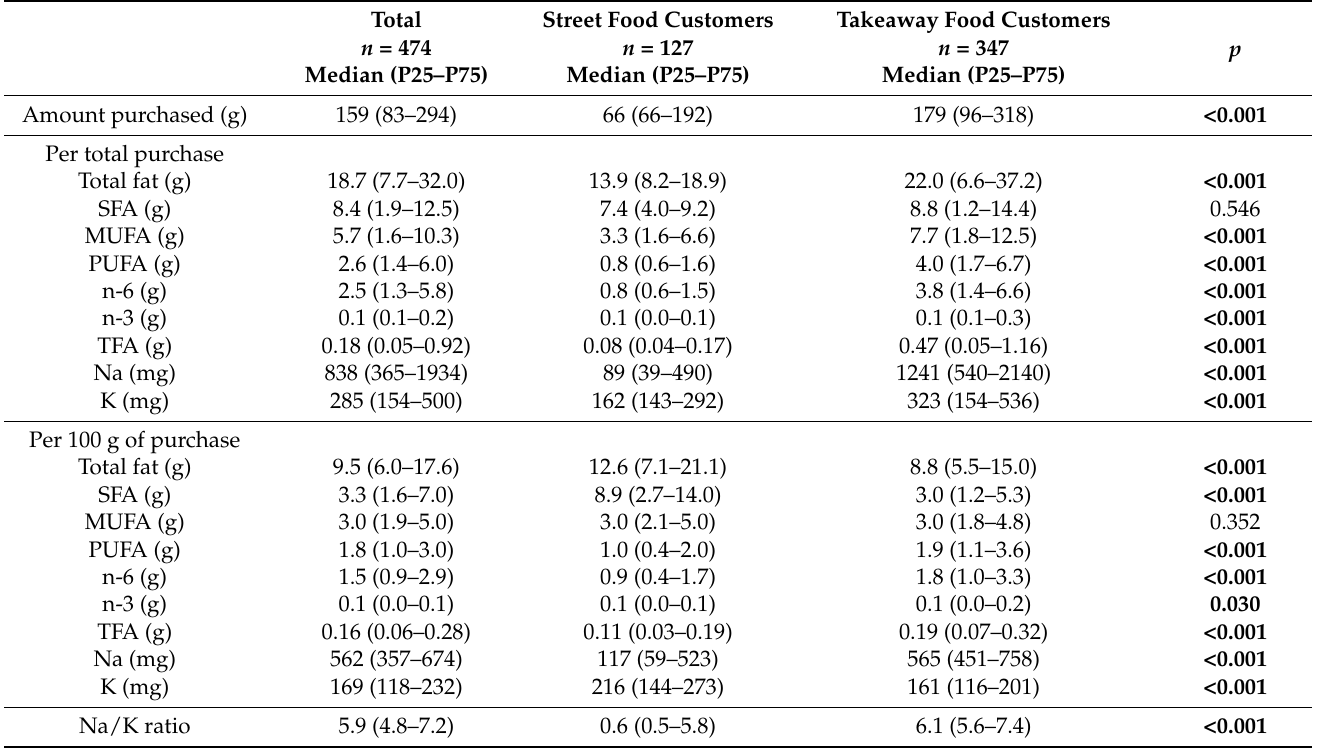
Table 2. Estimated fatty acids, sodium and potassium contents of the purchases made by a sub-sample ( n = 474 a ) of street food and takeaway food customers observed in Sarajevo and Banja Luka, Bosnia and